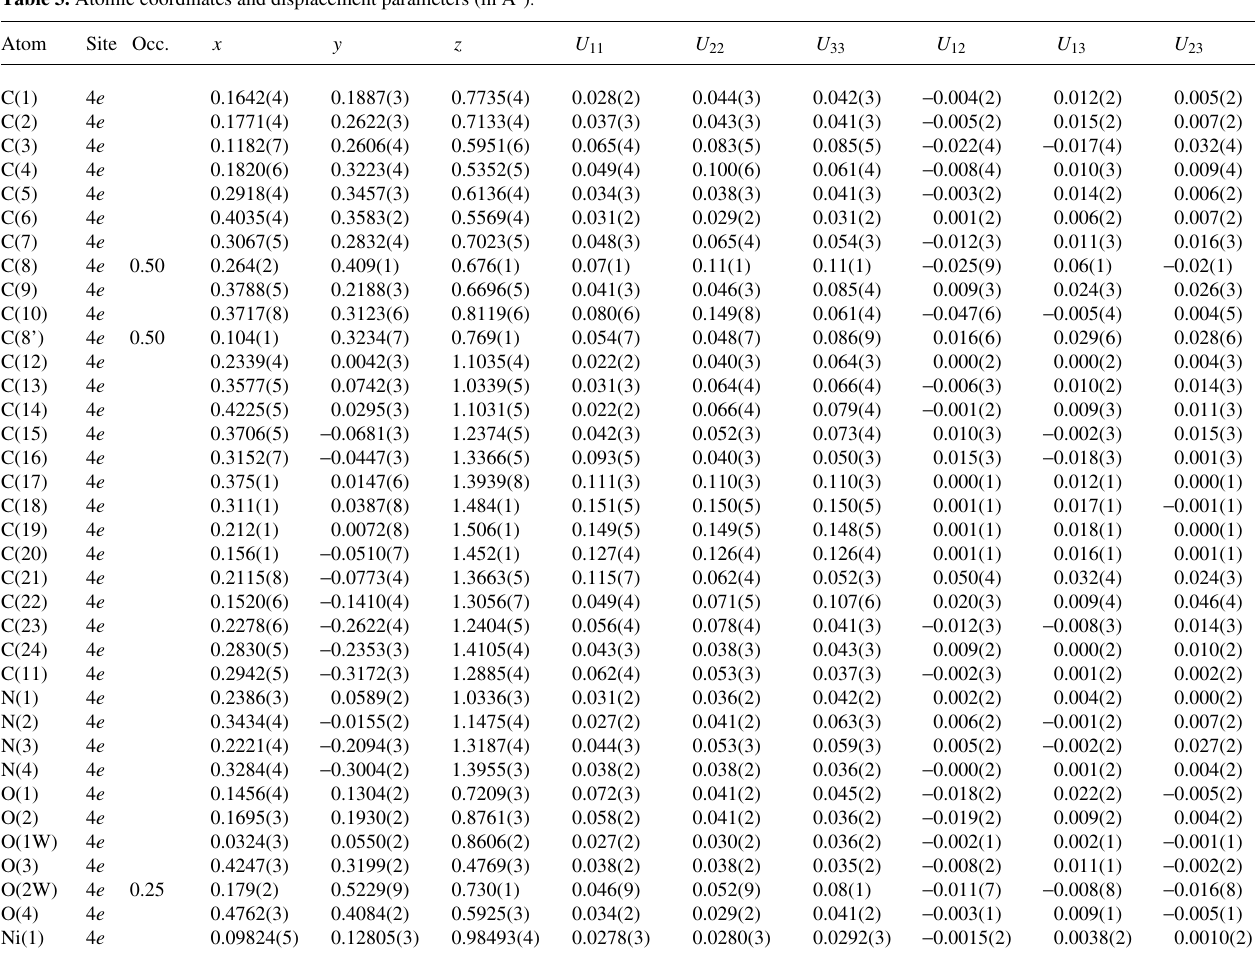
Table 3. Atomic coordinates and displacement parameters (in Å 2 )